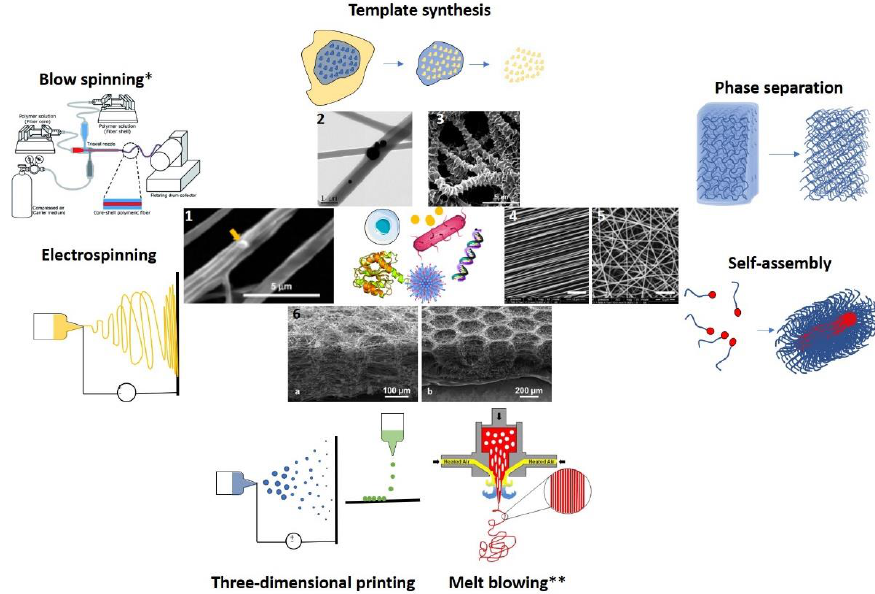
Figure 1. The overview of techniques for nanofiber fabrication. Some of the many possible nanofiber morphologies are presented in the central part: ( 1 ) Core-shell NFs obtained by microsol electrospin- ning loaded with liposomes (yellow arrow) . Adapted from [9]. Copyright © 2020, The Author(s) under CCBY licence. ( 2 ) Janus NFs loaded with AgNP and ciprofloxacin prepared by side-by-side electrospinning. Reprinted from [10] with permission from Elsevier. ( 3 ) Hierarchical shish-kebab core-shell NF prepared for growth factor delivery. Adapted with permission from [11]. Copyright